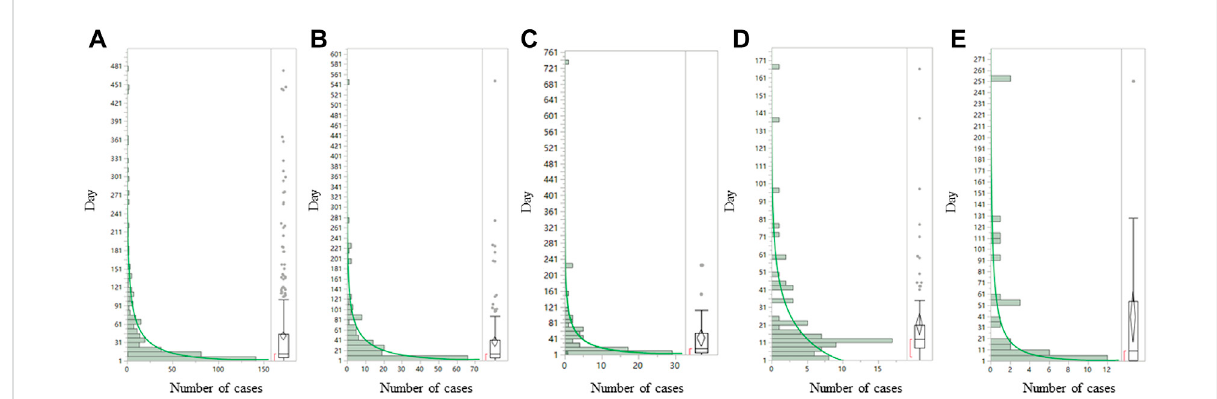
FIGURE 3 Time-to-onset analysis for (A) sepsis, (B) septic shock, (C) multiple organ dysfunction syndrome, (D) neutropenic sepsis, and (E) bacteremia associated with ADCs. ADCs, antibody – drug conjugates. The Y axis is days to onset and the X axis is the number of case (N) . The left side of each graph is a histogram and the right side is a box-and-whisker diagram with outlies. The green line on the histogram was drawn by fi tting the Weibull distribution.